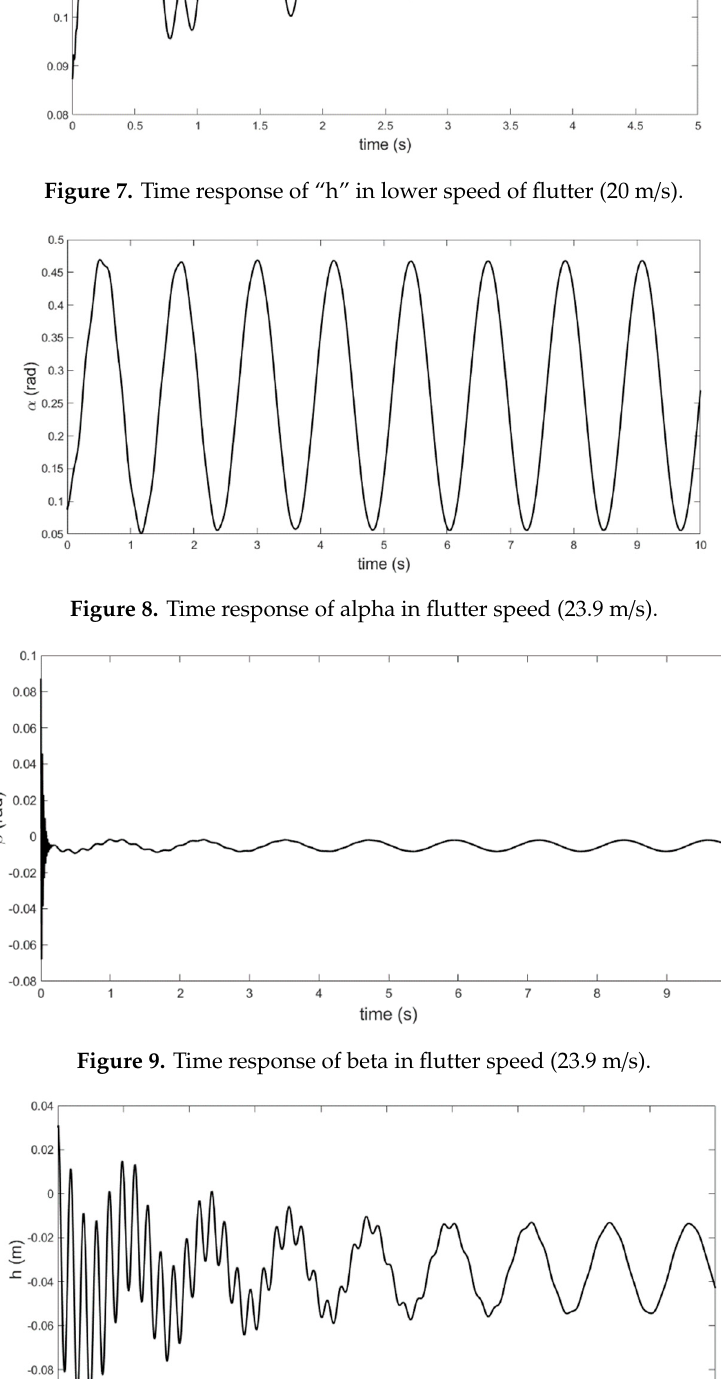
Figure 10. Time response of “h” in flutter speed (23.9 m/s).